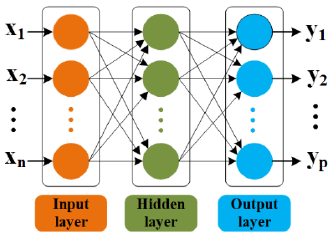
Figure 4. Basic architecture of feedforward neural network with three layers.